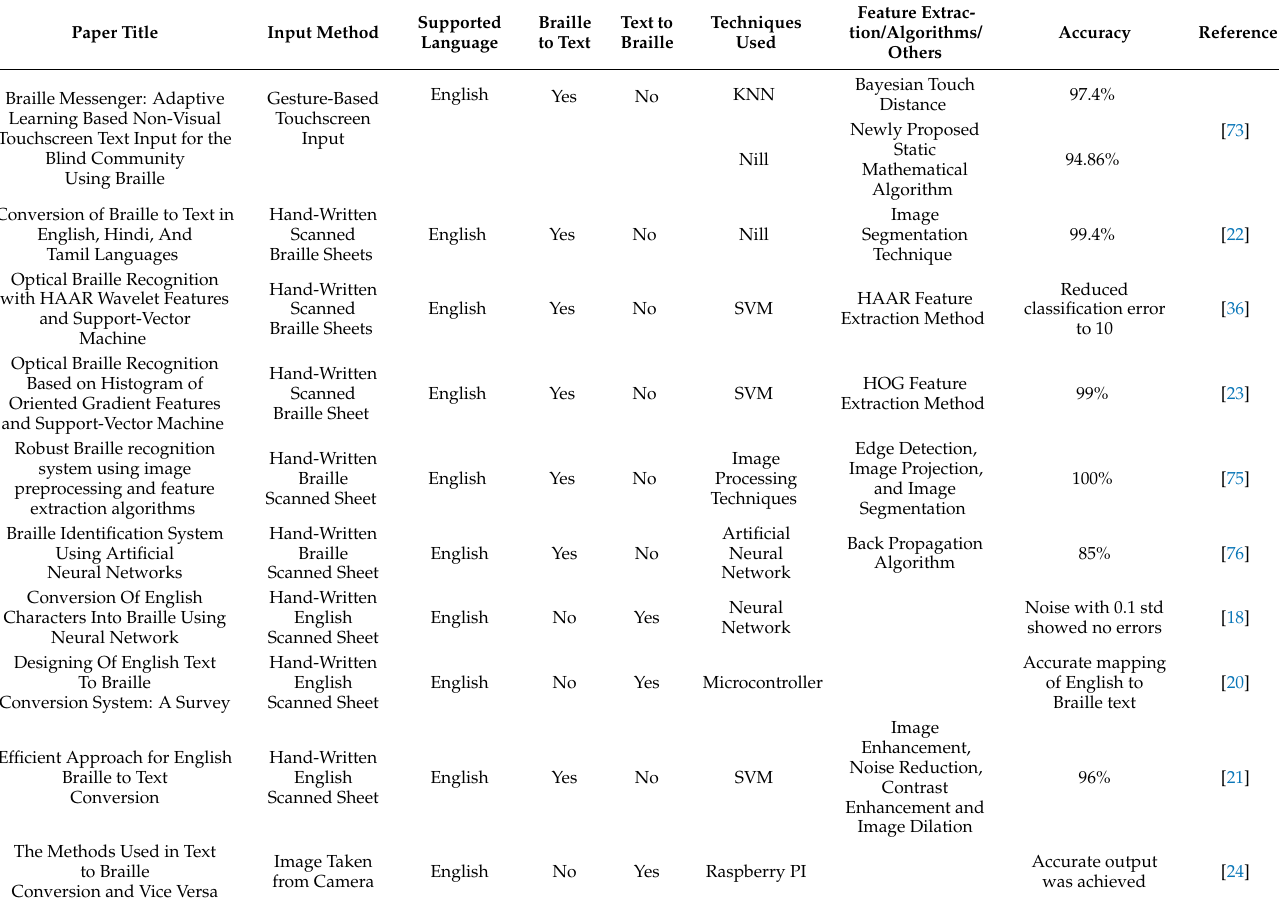
Table 7. Comparative analysis with previous